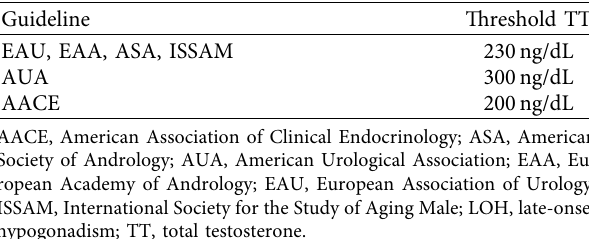
Table 4: Indications for free testosterone testing in